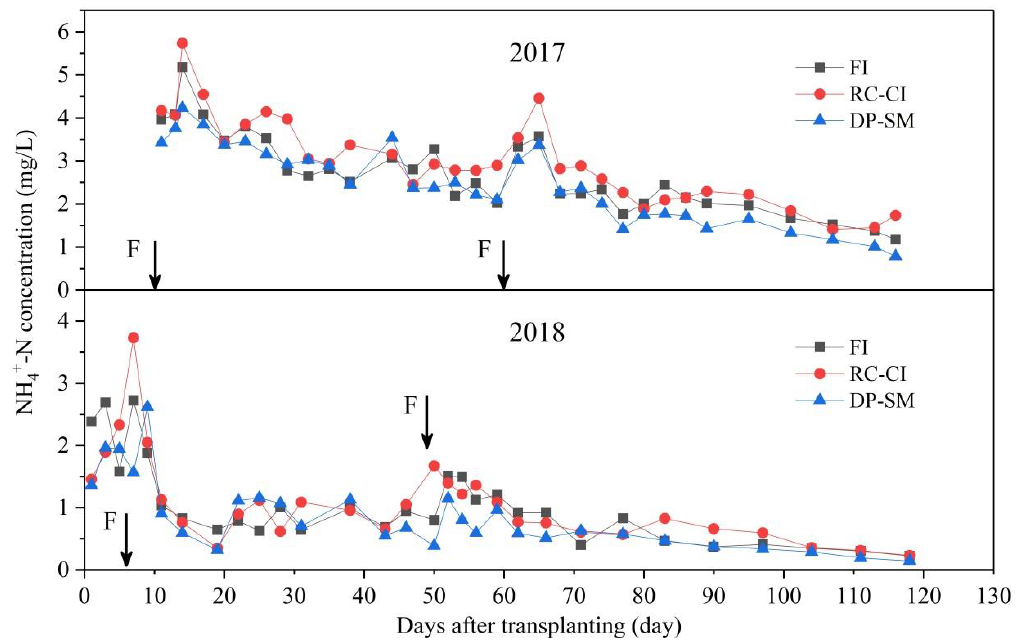
Figure 7. NH 4 + –N concentrations in percolation water under di ff erent irrigation regimes (The arrows Figure 7. NH4+-N concentrations in percolation water under different irrigation regimes (The arrows indicate indicate fertilization).